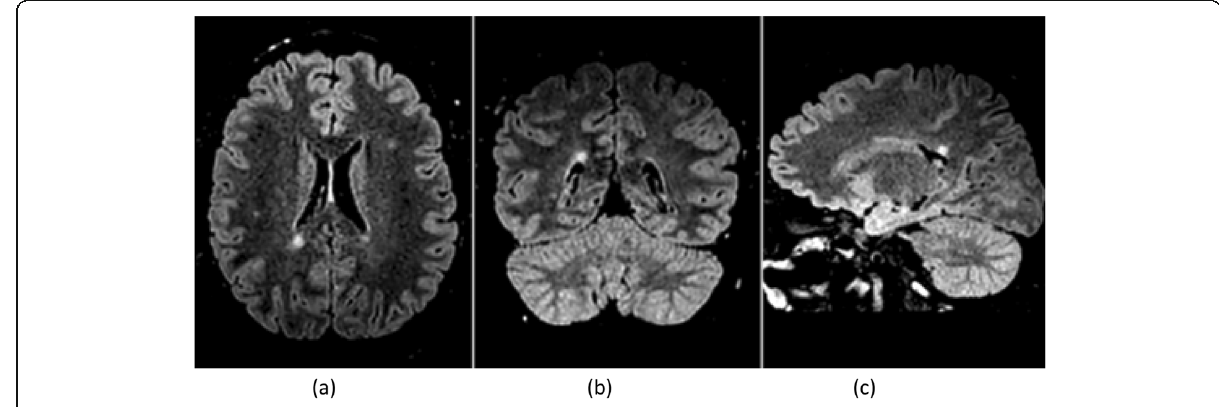
Fig. 1 Example of multiplanar. a Axial, b coronal, and c sagittal 3D-FLAIR